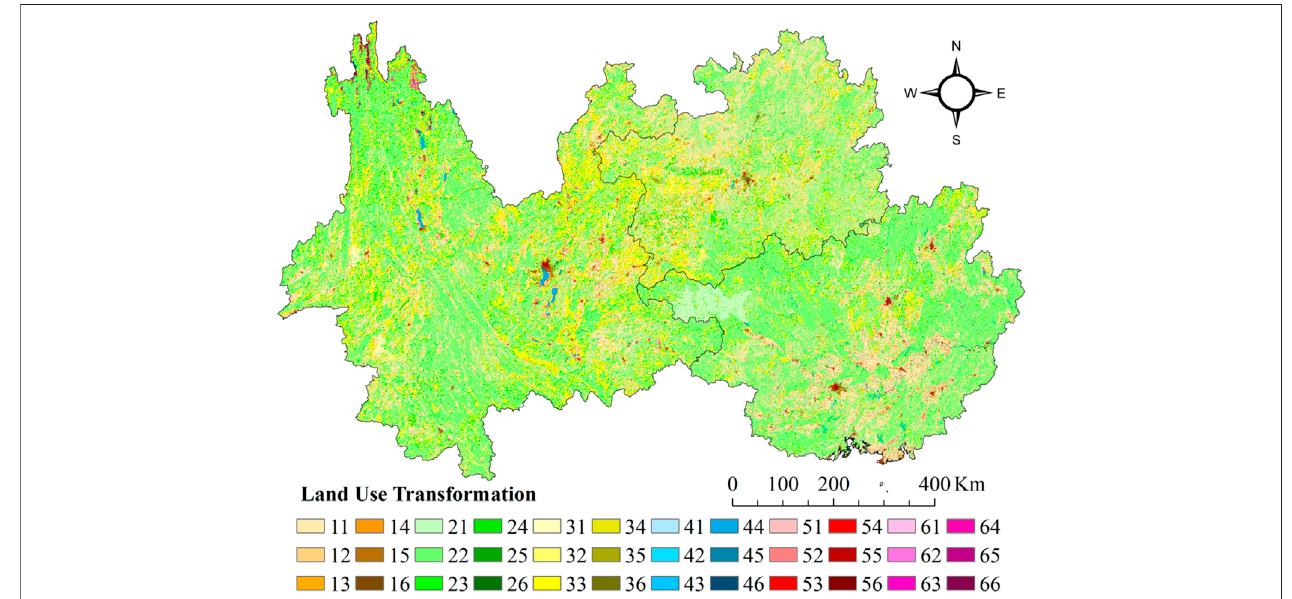
FIGURE 13 | Transfer matrix of land use in the three karst provinces of southwest China between 2000 and 2020 (km 2 ). Notes: 11-Transfer cropland to cropland, 12-Transfer cropland to forest land, 13-Transfer cropland to grassland, 14-Transfer cropland to water bodies, 15-Transfer cropland to bulit-up land, 21-Transfer forest land to cropland, 22-Transfer forest land to forest land, 23-Transfer forest land to grassland, 24-Transfer forest land to water bodies, 25-Transfer forest land to bulit-up land, 26-Transfer forest land to others, 31-Transfer grassland to cropland, 32-Transfer grassland to forest land, 33-Transfer grassland to grassland, 34-Transfer grassland to water bodies, 35-Transfer grassland to bulit-up land, 36-Transfer grassland to others, 41-Transfer water bodies to cropland, 42-Transfer water bodies to forest land, 43-Transfer water bodies to grassland, 44-Transfer water bodies to water bodies, 45-Transfer water bodies to bulit-up land, 46-Transfer water bodies to others, 51-Transfer bulit-up land to cropland, 52-Transfer bulit-up land to forest land, 53-Transfer bulit-up land to grassland, 54-Transfer bulit-up land to water bodies, 55-Transfer bulit-up land to bulit-up land, 56-Transfer bulit-up land to others, 61-Transfer others to cropland, 62-Transfer others to forest land, 63-Transfer others to grassland, 64-Transfer others to water bodies, 65-Transfer others to bulit-up land, 66-Transfer others to others.